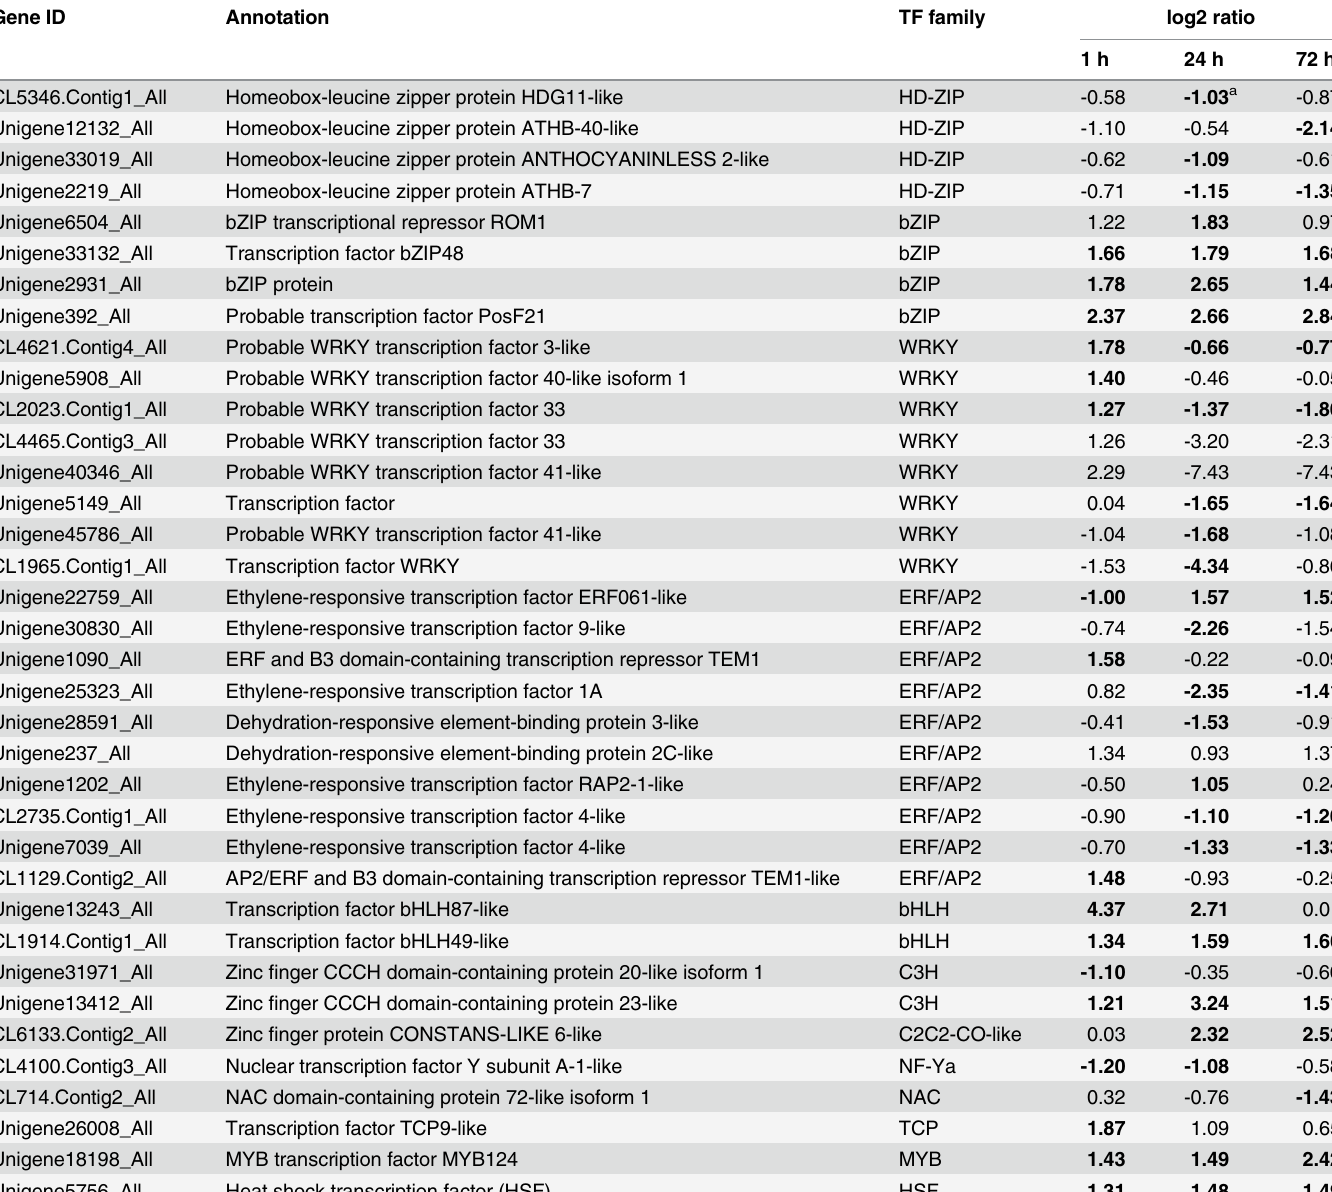
Table 5. Putative transcription factor genes regulated by drought stress in A . mongolicus . Gene